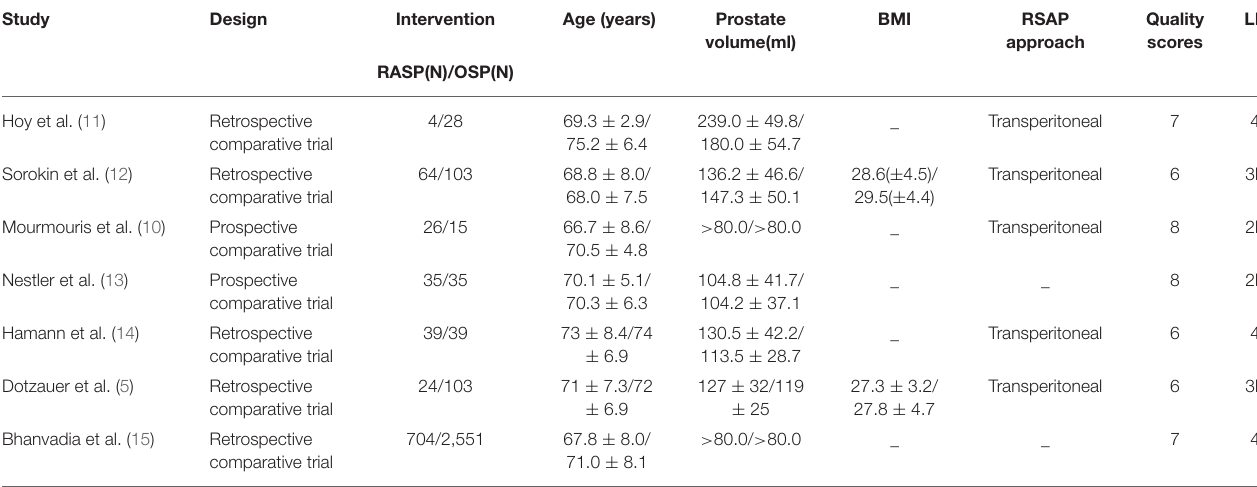
TABLE 1 | Basic characteristics and quality assessment of included studies.